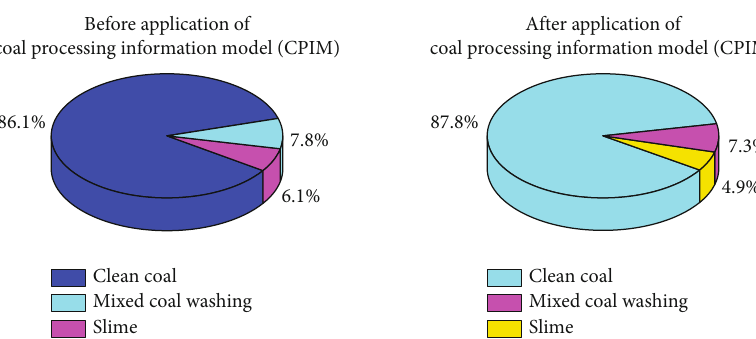
Figure 10: Comparison of coal preparation products between before and after application of Coal Processing Information Model (CPIM).